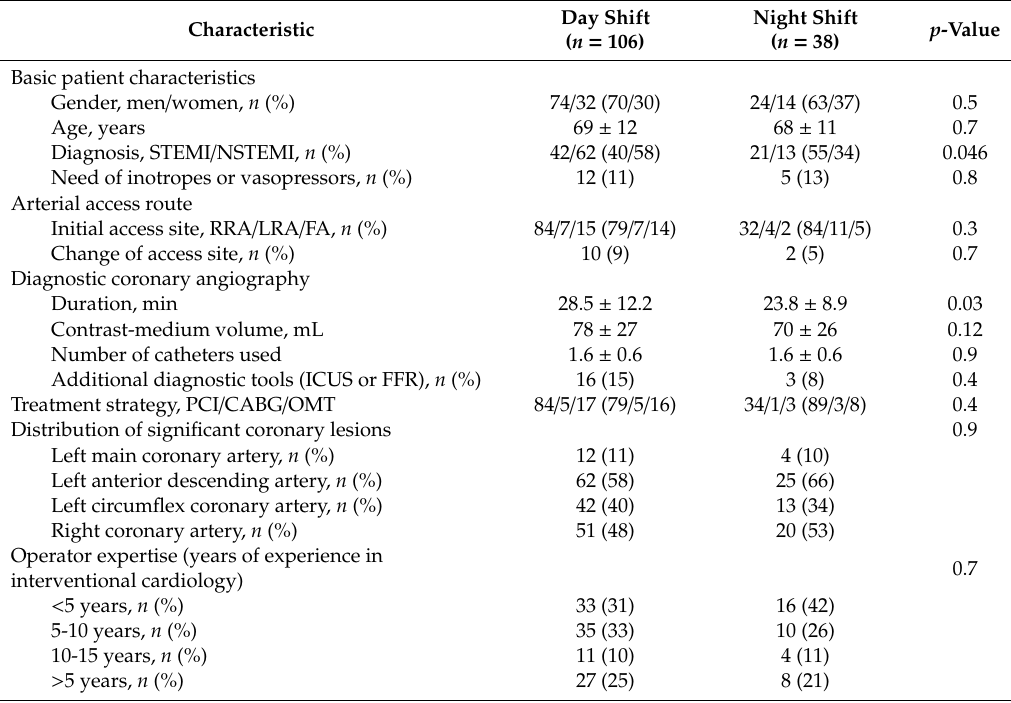
Table 1. Basic patient characteristics, procedural data and operator